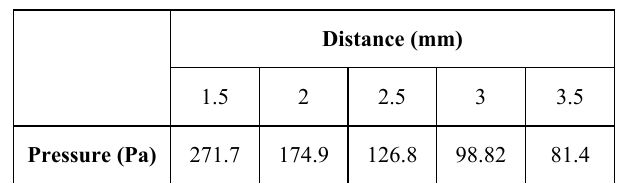
Table 4. Pressure